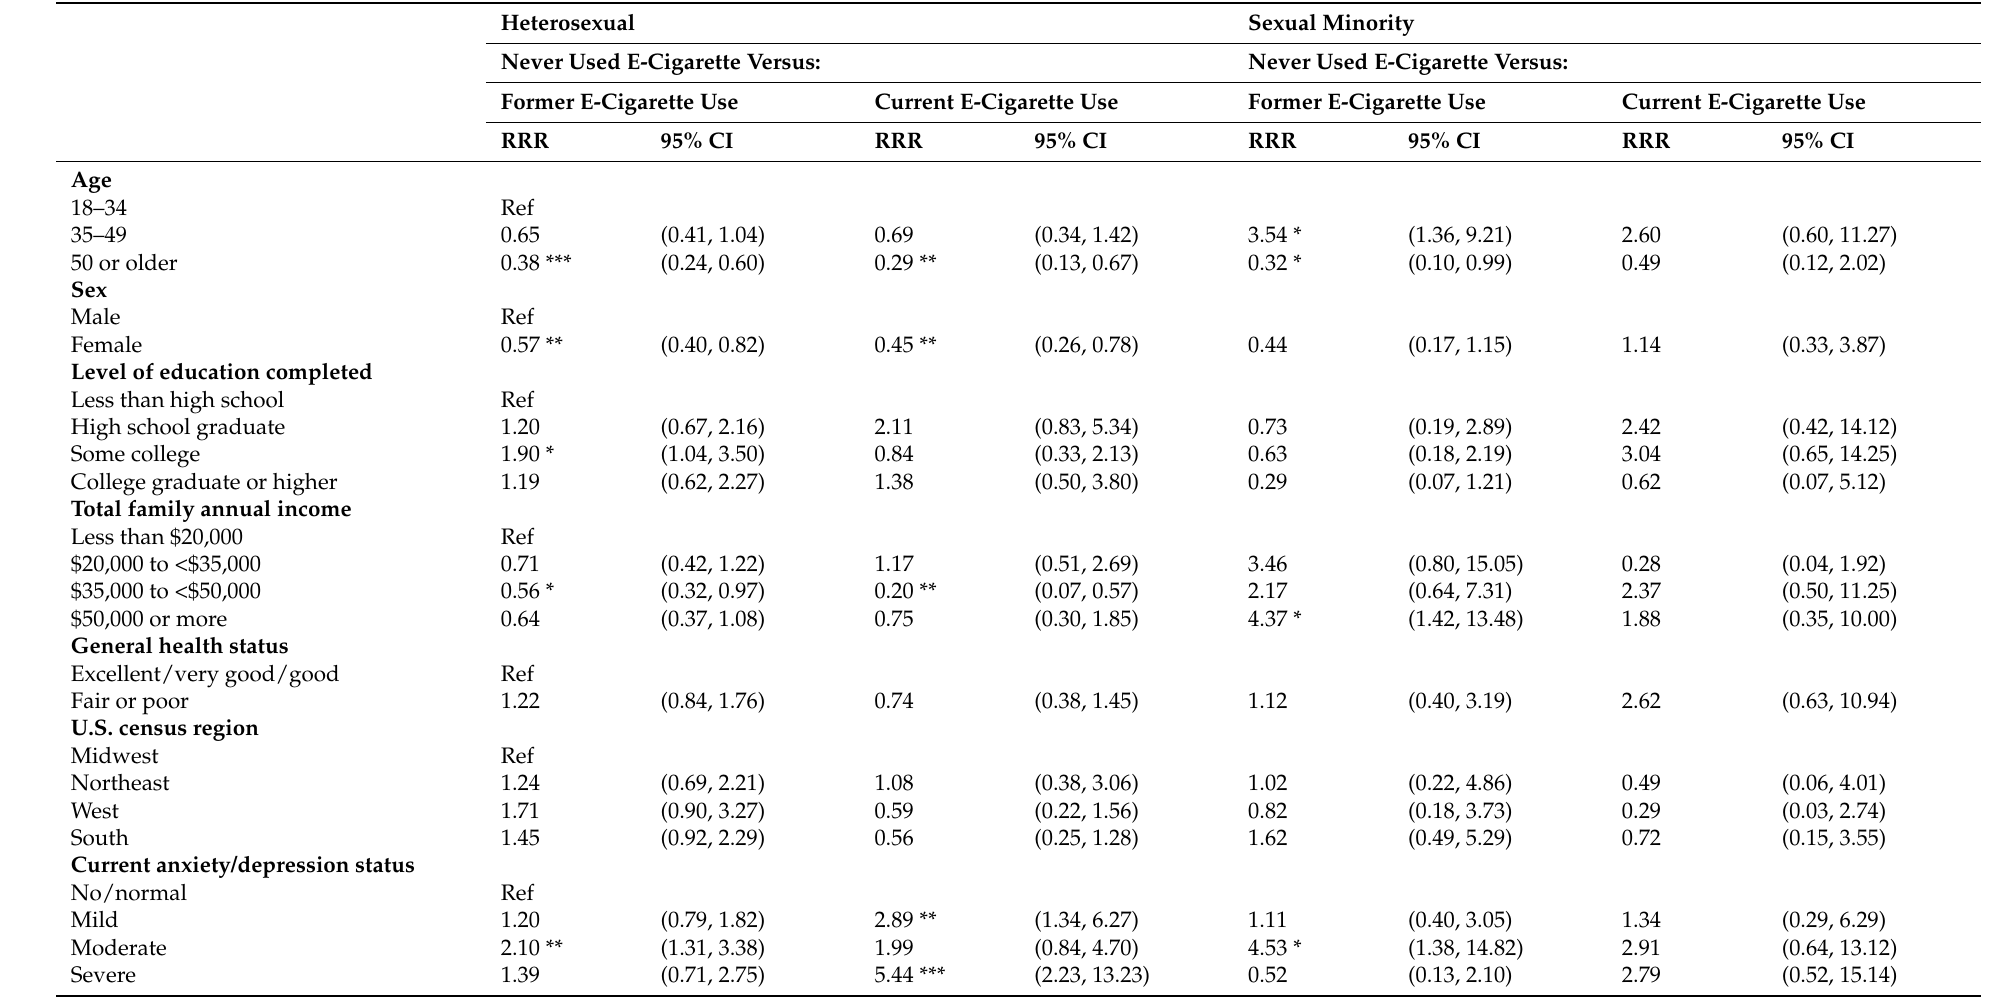
Table 2. Weighted multinomial logistic regression analysis of factors associated with e-cigarette use behaviors among Black/African American adults who identified as heterosexual vs. sexual minority